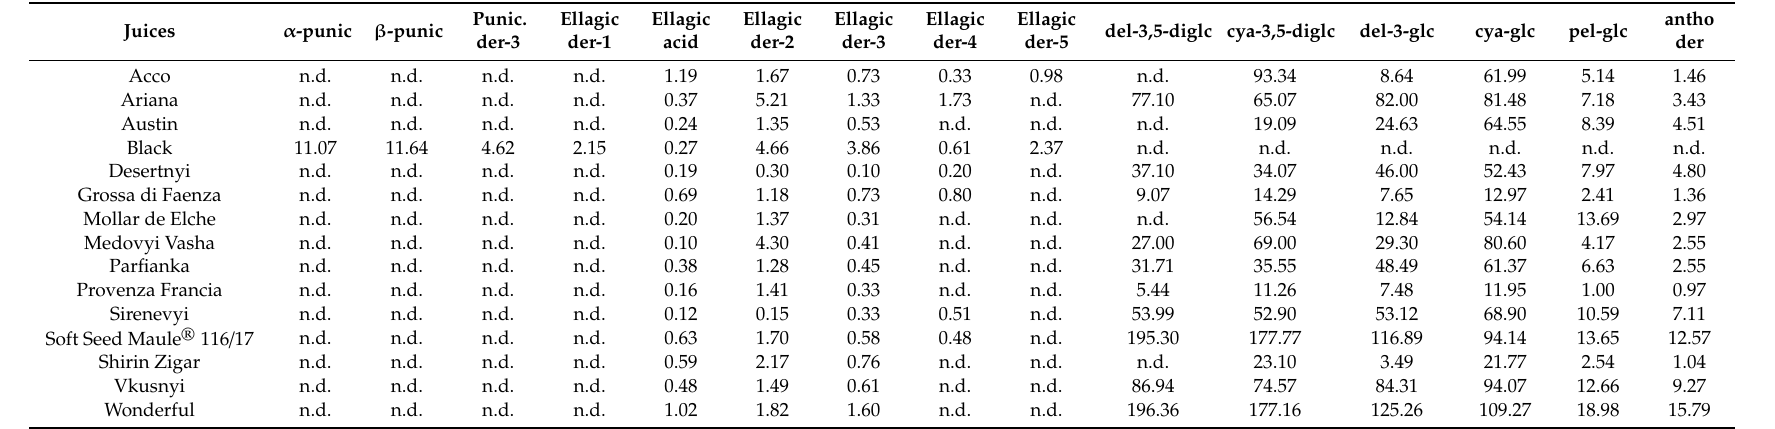
Table 3. Main phenolic compounds evaluated in the produced extracts for juices diluted 1:1 v / v with ethanol, with data expressed as mg / L; Punic., punicalagin; del-3,5-diglc, delphinidin-3,5- O -diglucoside; cya-3,5-diglc, cyanidin-3,5- O -diglucoside; del-3-glc, delphinidin-3- O -glucoside; cya-glc, cyanidin-3- O -glucoside; pel-glc, pelargonidin-3- O -glucoside; antho der, anthocyanin derivative; n.d.: not detected.